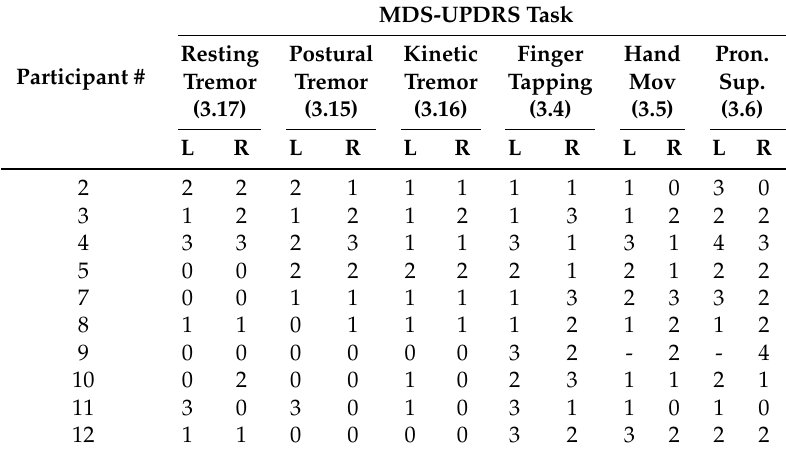
Table 2. Unified Parkinson’s Disease Rating Scale (UPDRS) evaluations (provided by a medical